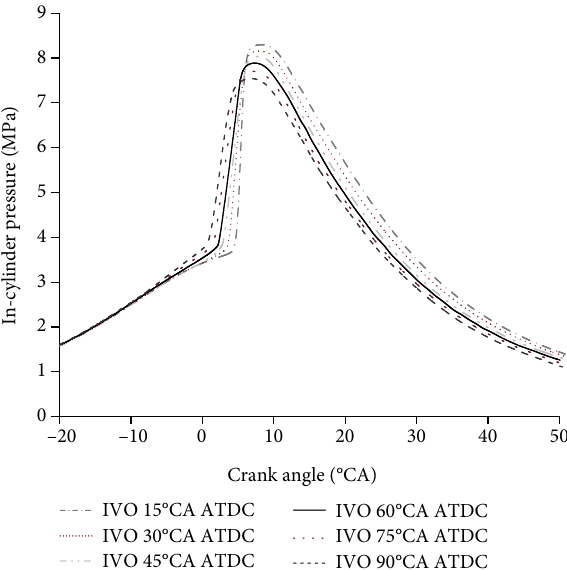
Figure 14: In fl uence of delayed IVO on